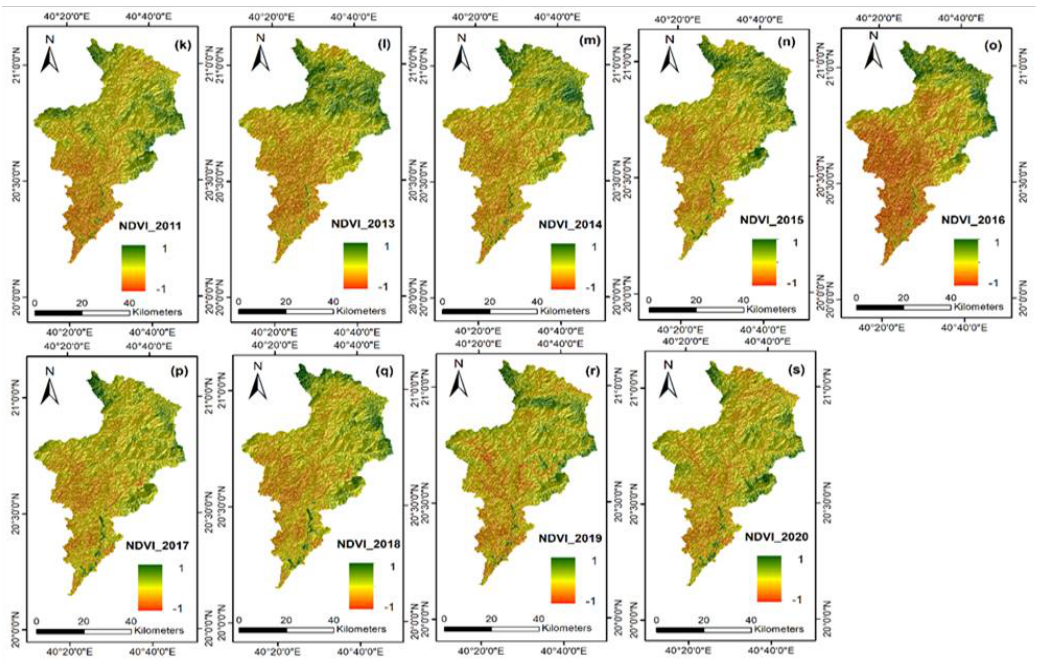
Figure A2 . Spatial distribution of NDVI in Al-Lith Watershed retrieved from Landsat Satellites